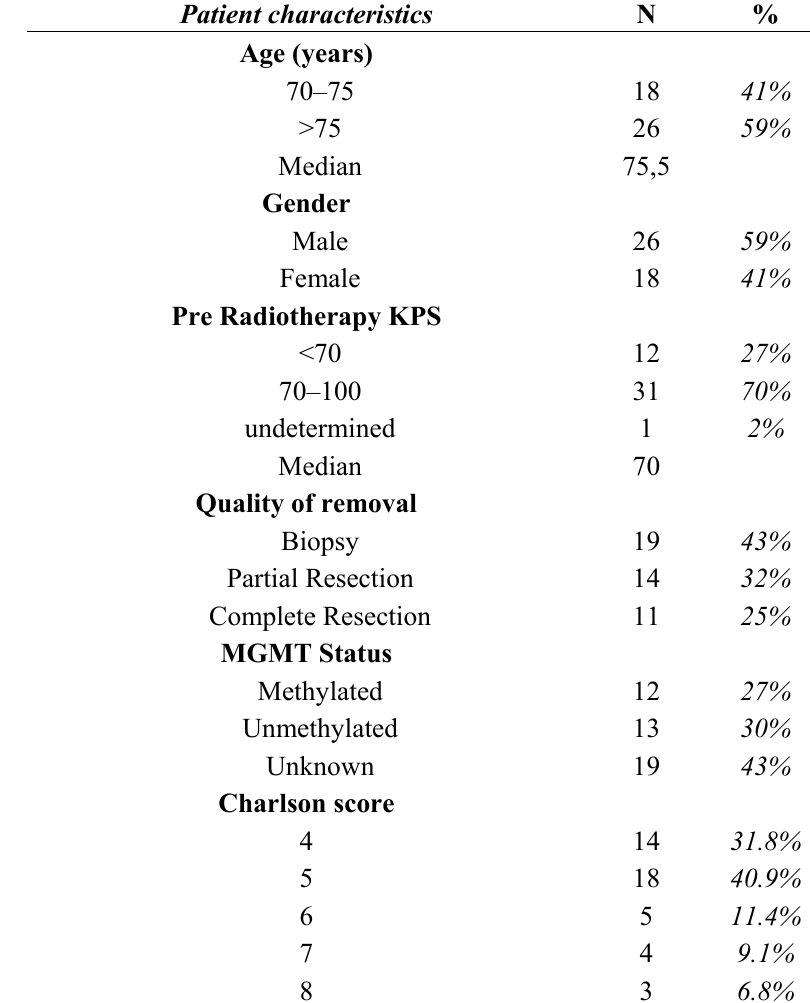
Table 1. Patients and treatment